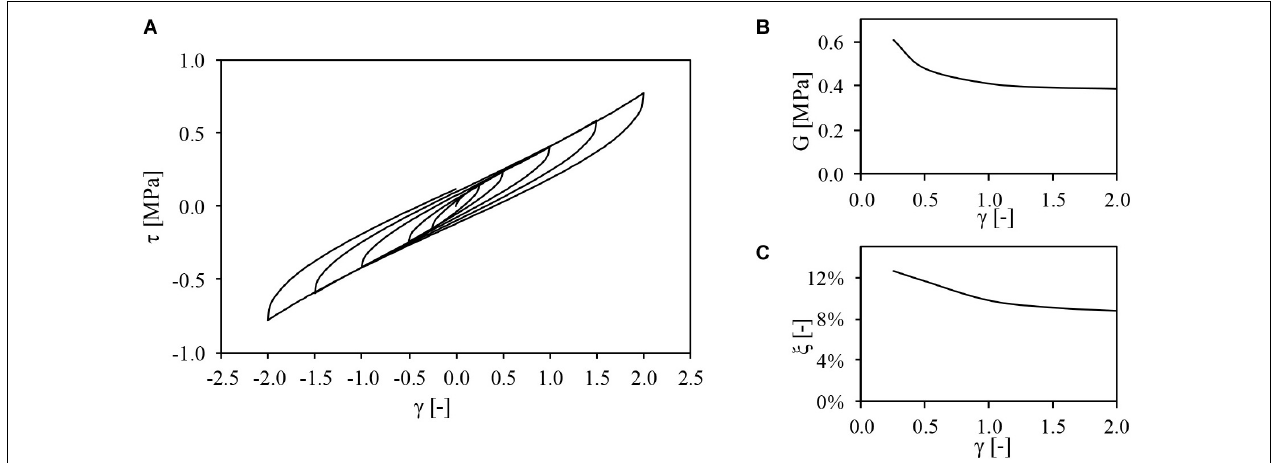
FIGURE 7 | Cyclic behavior of the HDR model of the Sap 2000 software (A) and trends pf equivalent stiffness (B) and equvalent damping (C) .